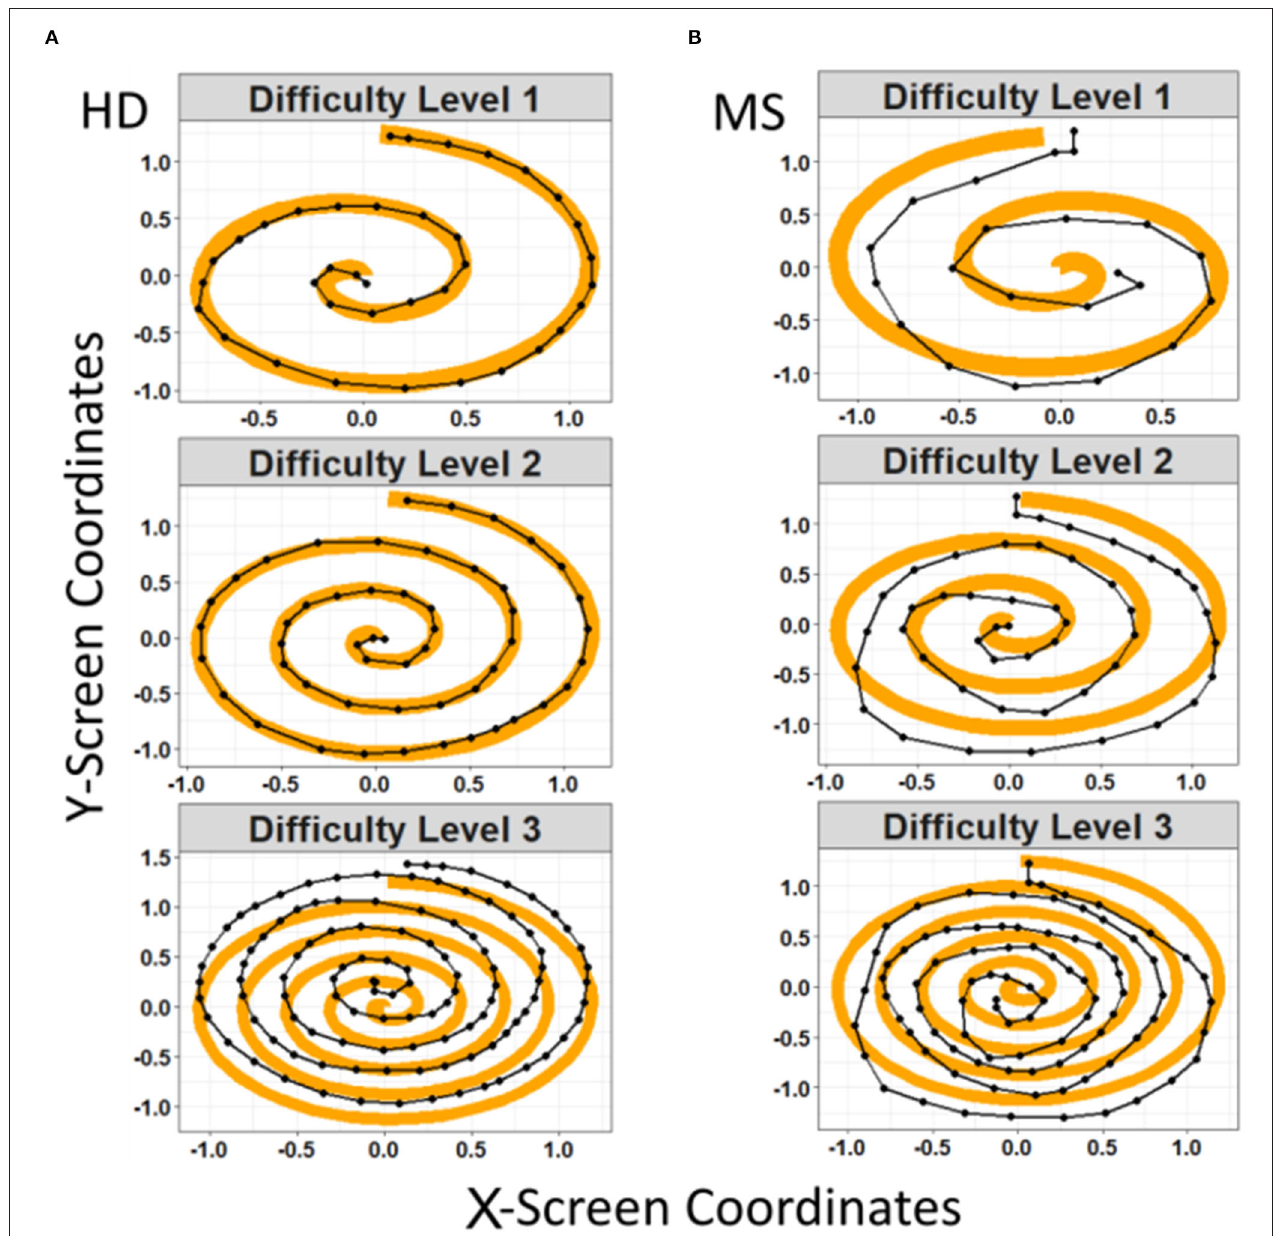
FIGURE 1 | Representation of the spiral tests performed on the smartphone by healthy donors (A) and patients with MS (B) . The orange and black spirals represent respectively the reference shape and the patient’s drawn shape (MS indicates multiple sclerosis patients, HD indicates healthy donors).